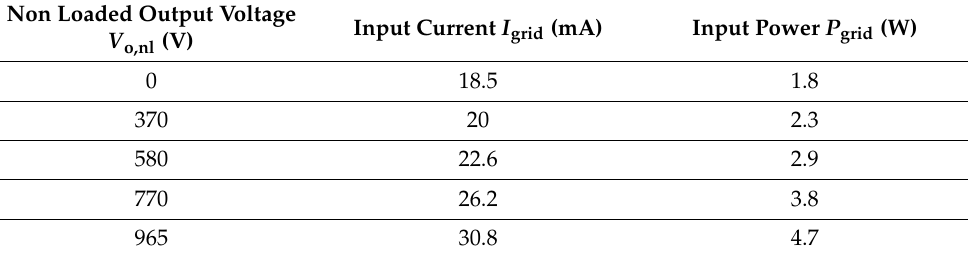
Table 3. Device consumption for different operation modes with a 1 ΜΩ resistive load.